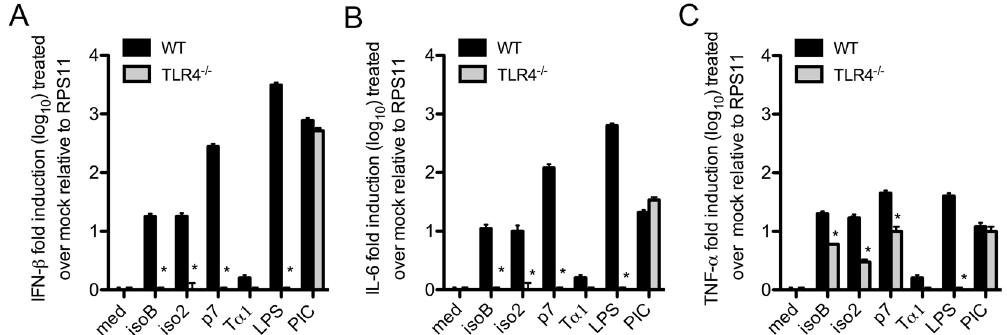
Fig 3. TLR4-dependent stimulation of IFN- β by ProT α variants. (A) IFN- β , (B) IL-6, and (C) TNF- α expression was measured by RT-qPCR on cDNAs from wild type and TLR4 -/- mouse bone marrow-derived macrophages treated with 200 ng/ml of different ProT α variants for 2 h. Though at lower levels, TNF- α remains inducible by the variants in TLR -/- murine macrophages, suggesting the possible involvement of other